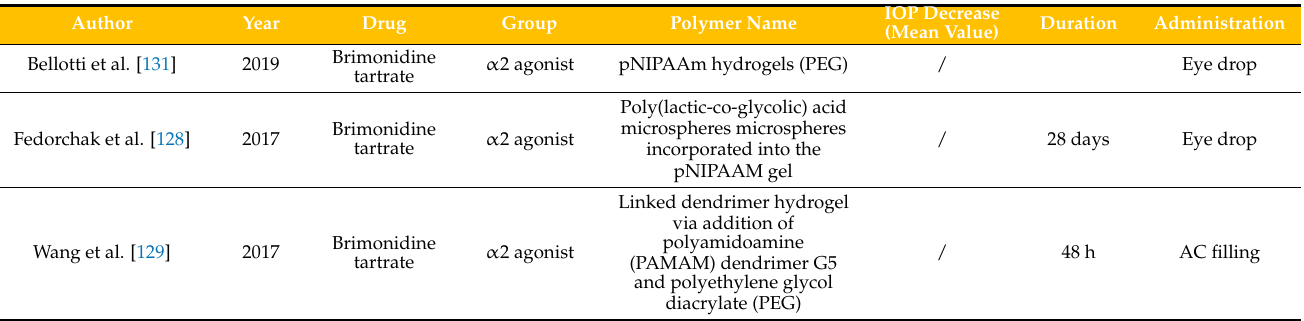
Table 2. Studies on drug delivery